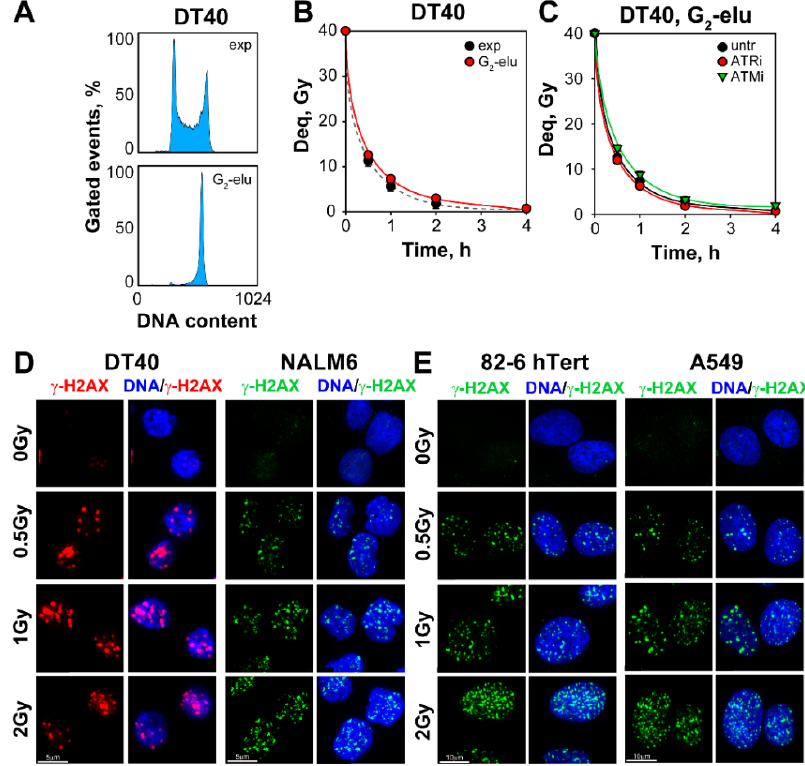
Figure 1. Contribution of HR to the repair of DSBs is undetectable by PFGE at high IR-doses: ( A ) Histogram plots representing the cell cycle distribution of DT40 cells before (exp) and after centrifugal elutriation (G 2 -elu); ( B ) Repair kinetics of exponentially growing cells (exp) and cells enriched in G 2 -phase of the cells cycle (G 2 -elu), irradiated with 40 Gy and analyzed by PFGE; ( C ) Repair kinetics of G 2 -phase-enriched DT40 cells, pre-treated or not with ATRi or ATMi; ( D ) IF images of γ -H2AX foci formation in DT40 and NALM6 cells, irradiated with the indicated doses of IR. Images are captured by an AxioScan Z1 platform and are utilized to generate the QIBC analysis data; ( E ) Same as Figure 1D, but for 82-6 hTert fibroblasts and A549 lung cancer cells.